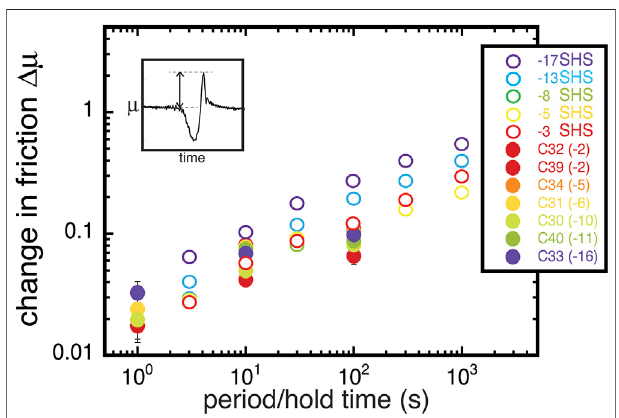
FIGURE 4 | Frictional amplitude (inset) vs . period of forcing from this study (closed symbols) for those cycles that approach and reach zero velocity compared to change in friction and log hold time from previous slide-hold- slide experiments (open symbols) (McCarthy et al., 2017).